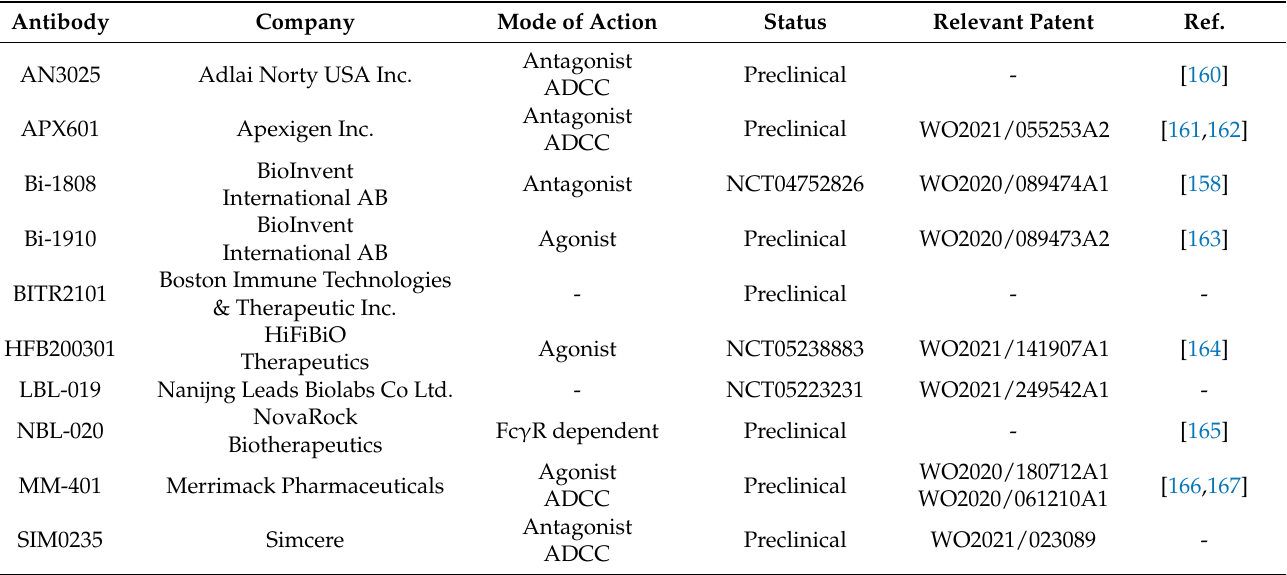
Table 2. Translational TNFR2-targeting